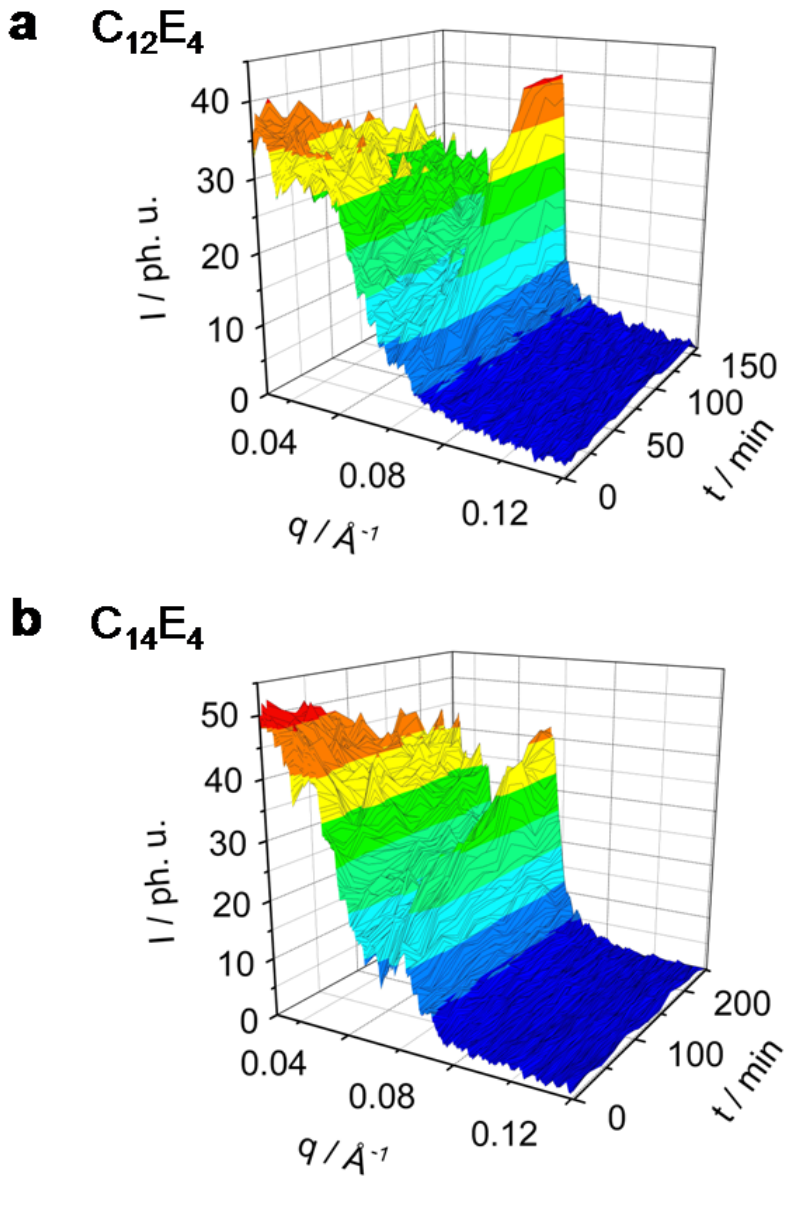
Figure 3. Rh101 dye-sensitized ME → LC phase transition in the system C C E ( b ) investigated by TR-SAXS. Both systems undergo the phase transition only to 14 4 less than 80%. The C significantly longer (200